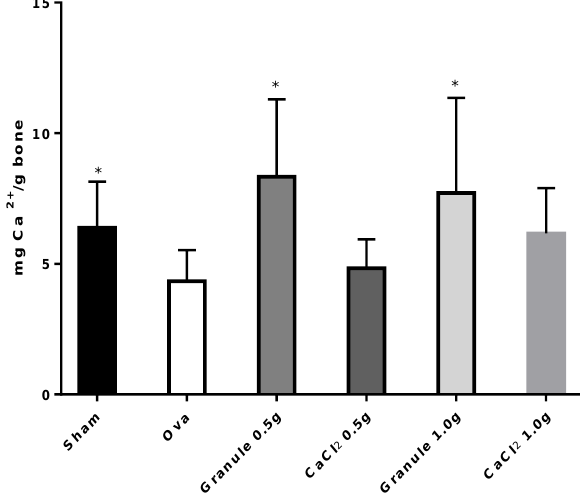
Figure 4. Ca 2 + quantity (mg) per g of bone in rat femur. * p < 0.05 versus Ova Figure 4. Ca 2+ quantity (mg) per g of bone in rat femur. * p < 0.05 versus Ova Group.